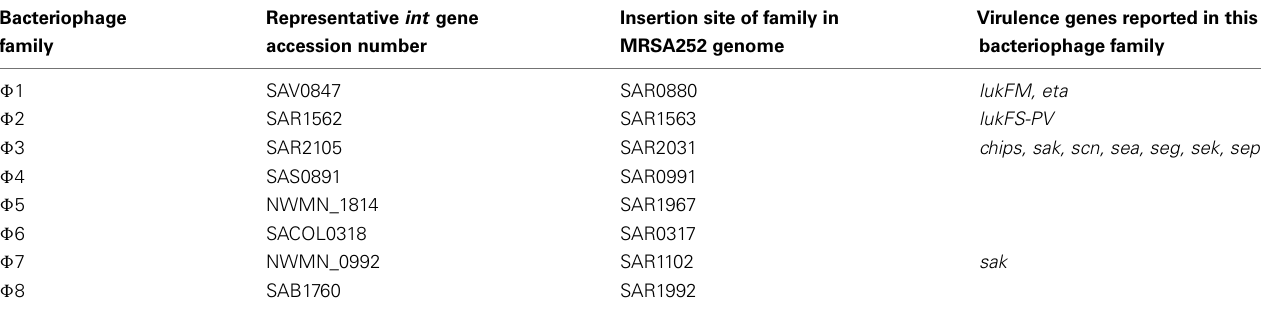
Table 1 | Classification of S. aureus